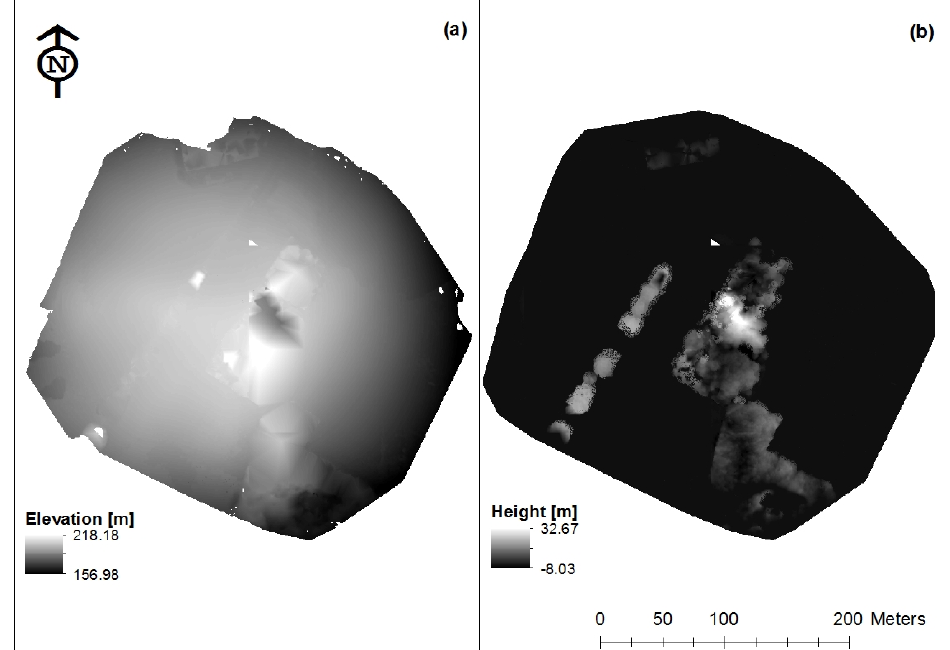
Figure 8. Showing ( a ) DEM and ( b ) CHM for the Dryden site generated by SfM. In ( a ) the ground elevation in canopy regions is significantly higher than that in bare regions due to lack of canopy penetration by SfM.